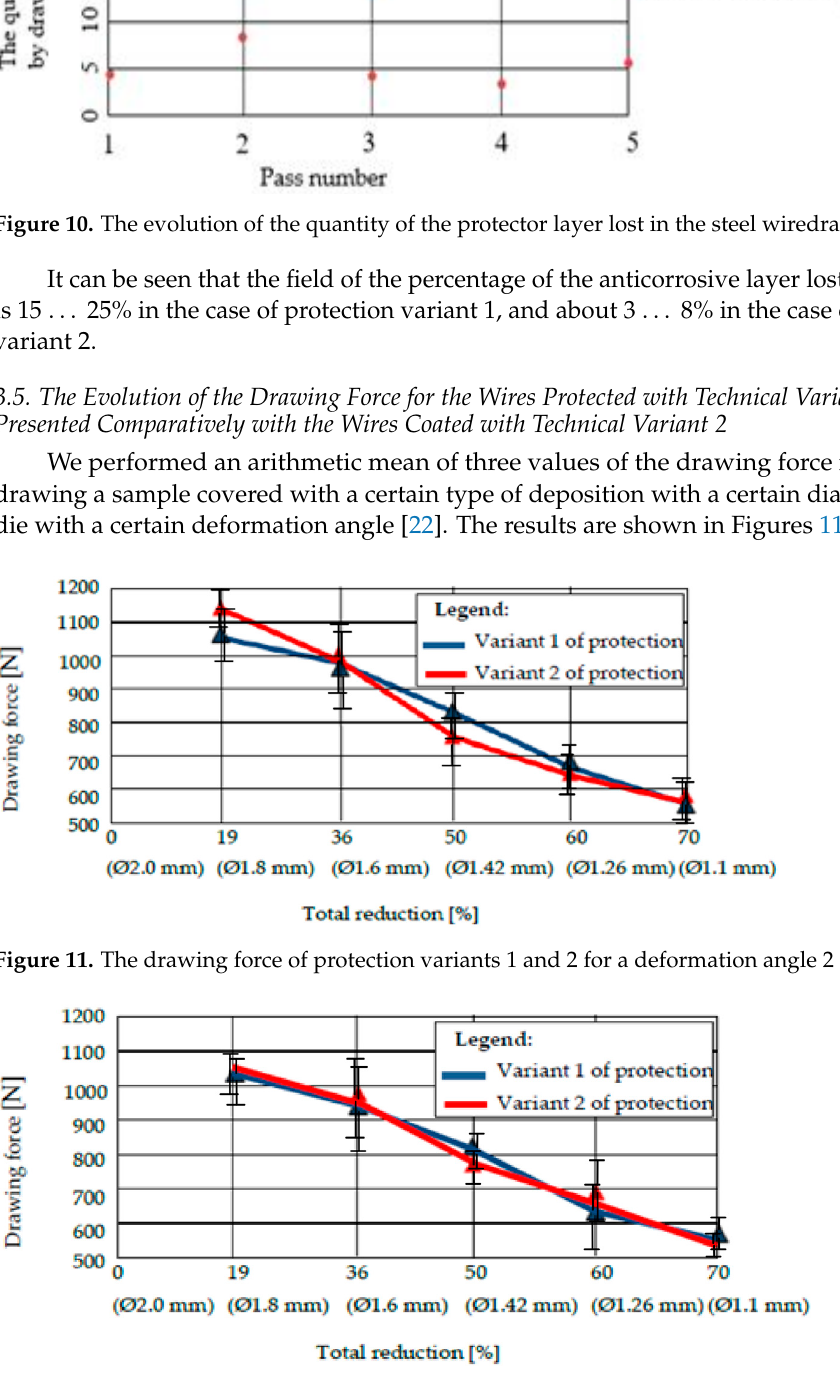
Figure 12. The drawing force of protection variants 1 and 2 for a deformation angle 2· α = 12°.